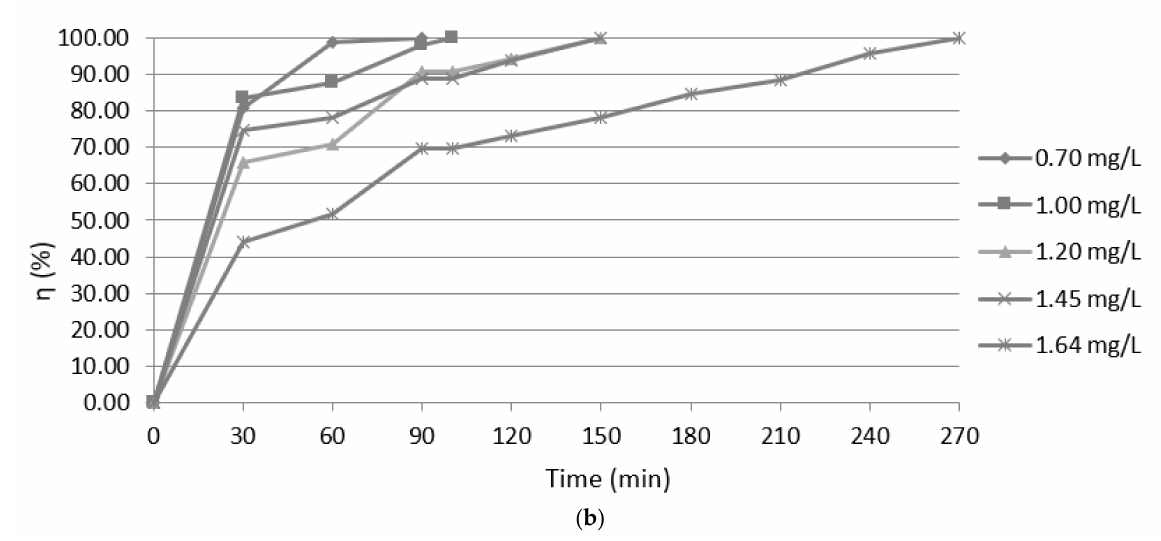
Figure 4. Efficiencies of wastewater treatment versus time at pH 4 ( a ) and pH 6 ( b ).